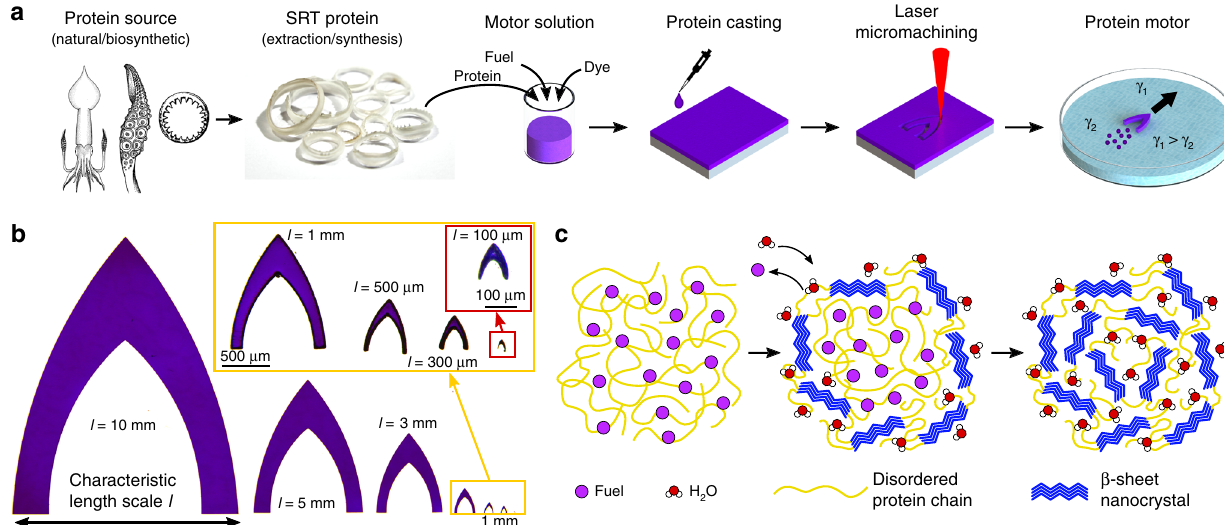
Fig. 1 Self-propelled protein motors. a Fabrication of protein motors: production of the protein either from natural or biosynthetic sources (adapted from reference with permission 54 ), SRT extraction and puri fi cation, preparation of the motor solution (with SRT protein, fuel, and dyes), protein fi lm casting, laser micromachining of the motors to the speci fi ed design shape, and self-propulsion by Marangoni forces at the air – liquid interface. b Fabricated protein motor top-view images with characteristic length scales from 10 mm down to 100 μ m. c Propulsion mechanism : HFIP fuel is initially trapped in the protein matrix, and it is released to the swimming medium when the motor comes in contact with water. Trapped HFIP molecules are replaced by water, inducing the formation of β -sheet